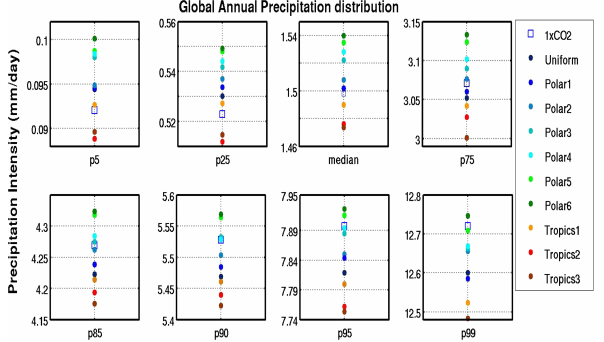
Figure 10. Percentile values (p5, p25, median, p75, p85, p90, p95 and p99) of precipitation intensity over Globe. There is a monotonic increase in precipitation for all percentile values as the maximum concentration of aerosols over poles increases. Grid-level monthly mean precipitation are used to calculate the percentile values. The last 30 years of 60-year simulations are used for the statistics.